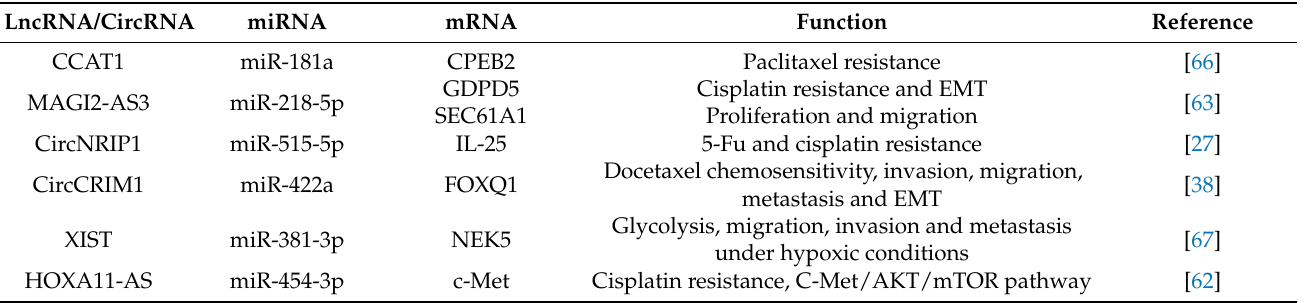
Table 3. CeRNA networks of lncRNA/circRNA-miRNA-mRNA involved in NPC